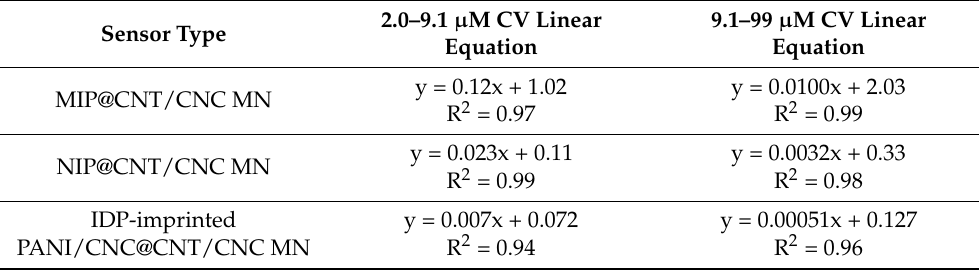
Table 2. Linear CV calibration equations for MIP@CNT/CNC, NIP@CNT/CNC, and imidacloprid